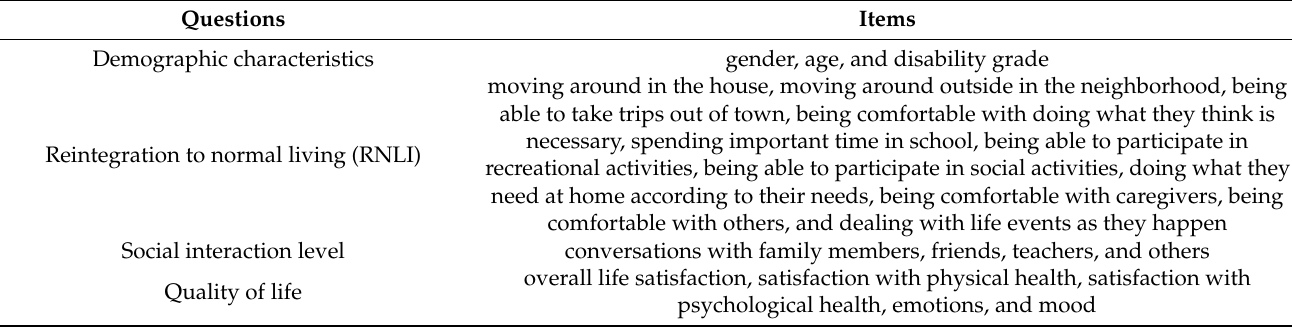
Table 1. Pre- and post-survey